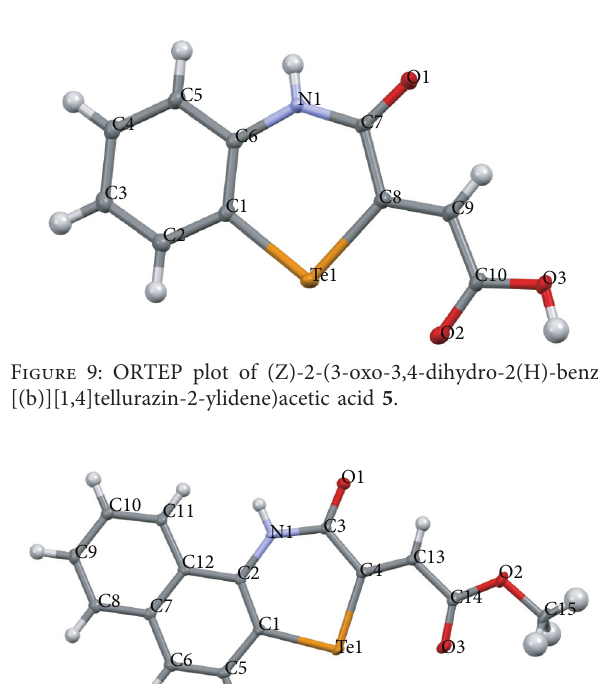
Figure 8: Access to 1,5-tellurazepinones by tandem aminolysis/exo-dig addition (benzene derived: R � (H) CH R � CH 3 ).